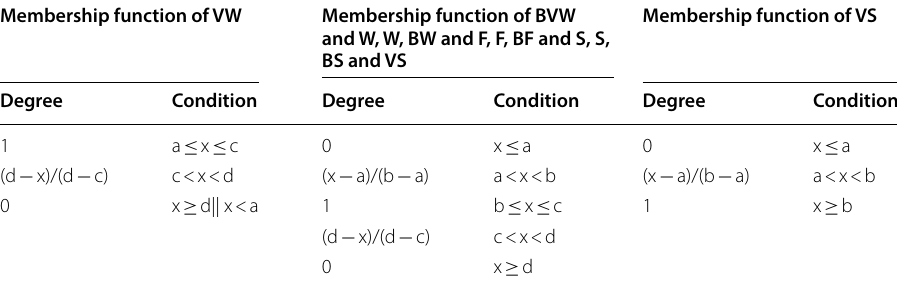
Table 5 Parameters of membership functions for linguistic values of occurence Membership function of